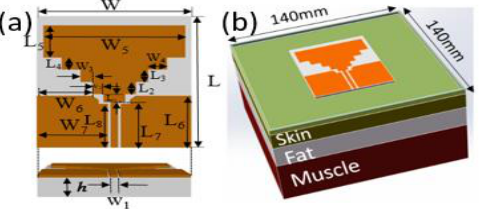
Figure 4. ( a ) Structural Diagram of Antenna ( b ) Construction of Human Tissue.